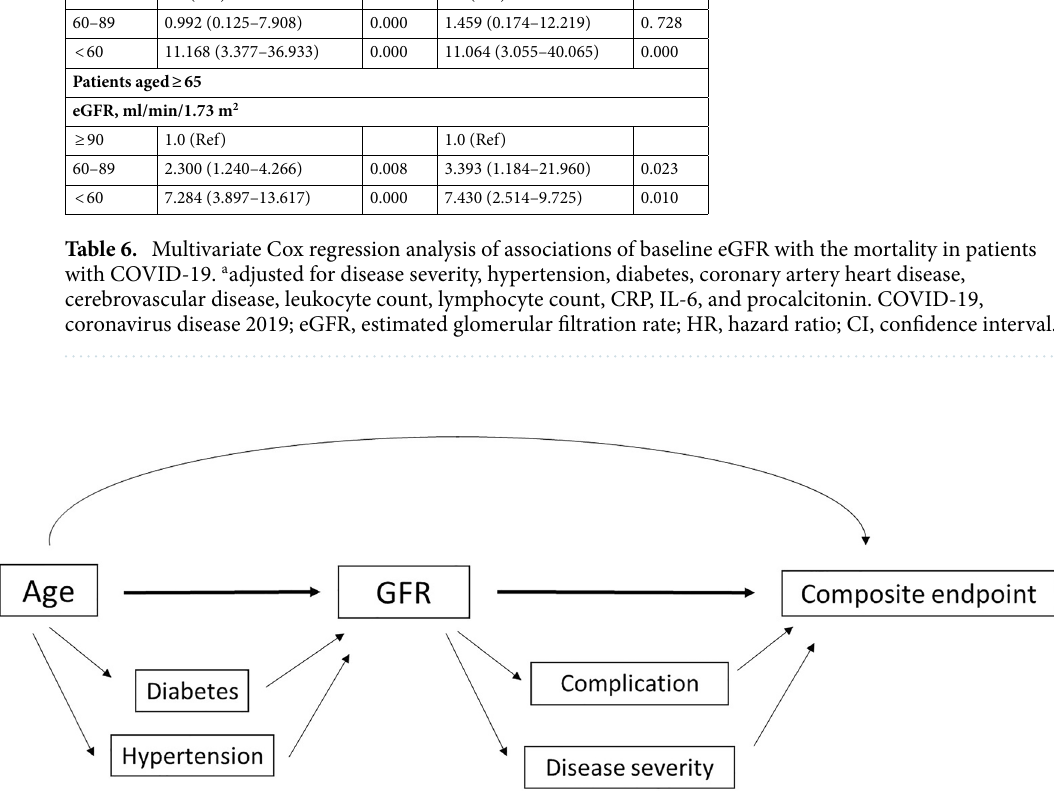
Figure 3. A directed acyclic graph (DAG) showing the association between risk factors and the poor prognosis of